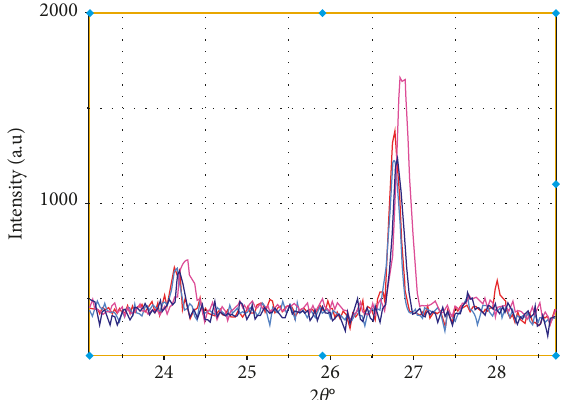
Figure 11: Peaks comparison with combined XRD curves.